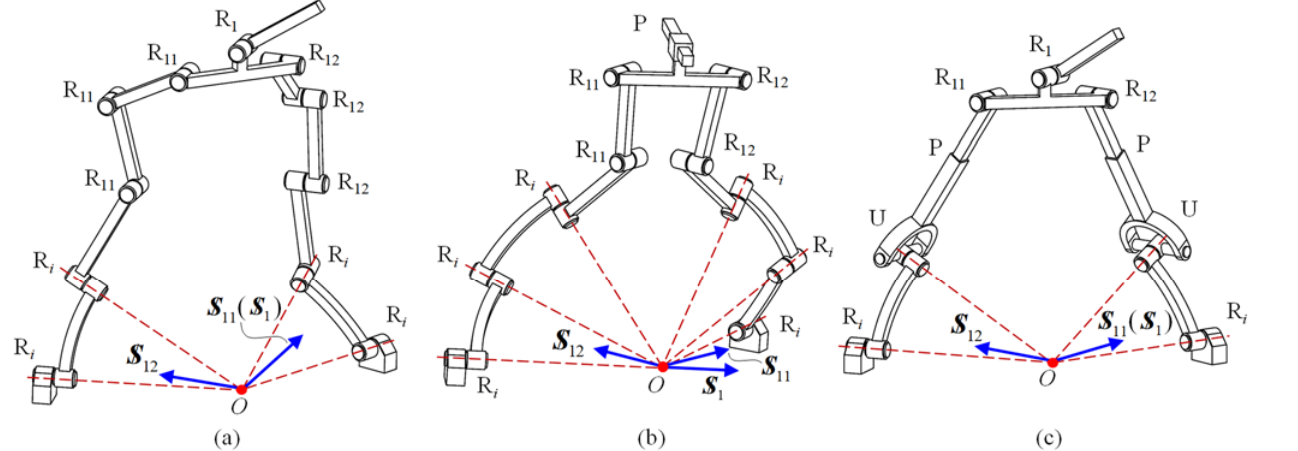
Figure 3. Typical F ‐ hybrid limbs in the first class: ( a ) [R i R i R 11 R 11 R 11 ‐ R i R i R 12 R 12 R 12 ] ‐ R 1 , ( b ) [R i R i R i R 11 R 11 ‐ R i R i R i R 12 R 12 ] ‐ P, ( c ) [R i UPR 11 ‐ R i UPR 12 ] ‐ R 1 , ( d ) [R i R i CR 11 ‐ R i R i CR 12 ] ‐ P, ( e ) [R i CPR 11 ‐ R i CPR 12 ] ‐ R 1 , ( f ) [R i R i PPR 11 ‐ R i R i PPR 12 ] ‐ P. In Figure